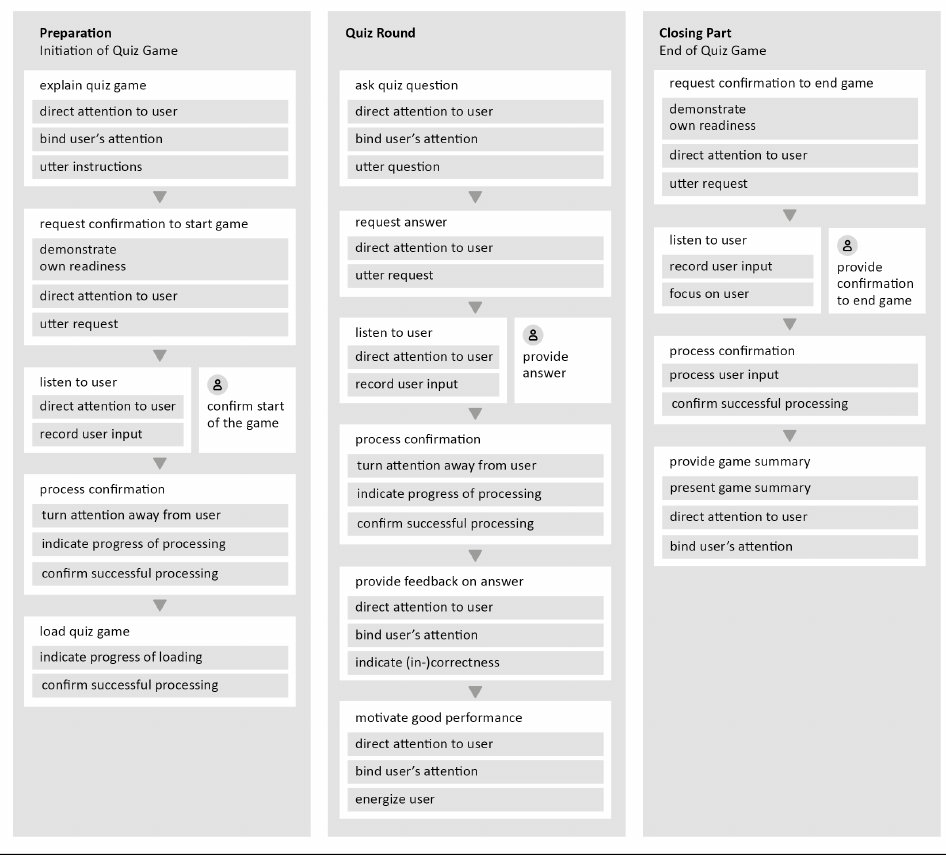
Figure 2. Flow chart depicting the EUCs for the preparation part, one round of the quiz game and the closing part. Table 2. Overview of the recurring robot main and sub-actions and the associated communication